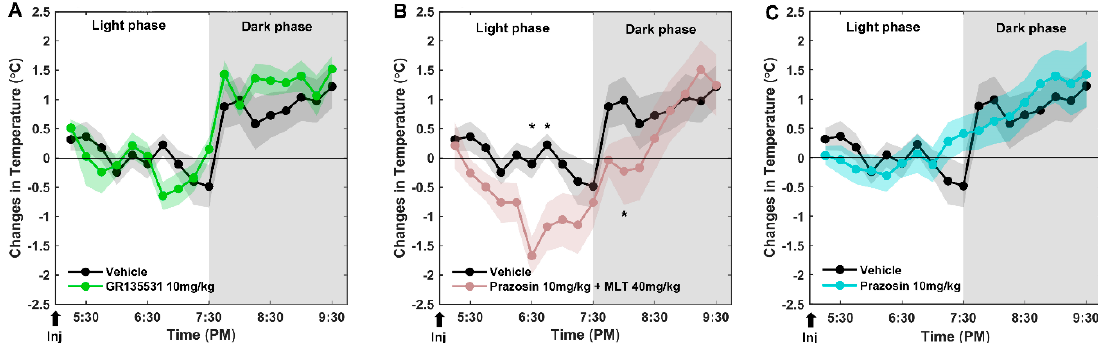
Figure 5. ( A ) Changes in T b after the administration of the MLT MT 3 agonist GR135531 (10 mg/kg) during the dark phase. ( B ) Prazosin (10 mg/kg) pre-treatment does not block the effects of MLT on T b during the light phase. ( C ) Prazosin (10 mg/kg) injected during the light phase does not affect T b . Data are expressed as mean ± SEM (graded shades). Lights off at 7:30 p.m. * p < 0.05 versus vehicle; two-way ANOVA for repeated measures followed by Bonferroni post hoc test. Inj: s.c. injection of either vehicle, GR135531, MLT + prazosin, or prazosin.